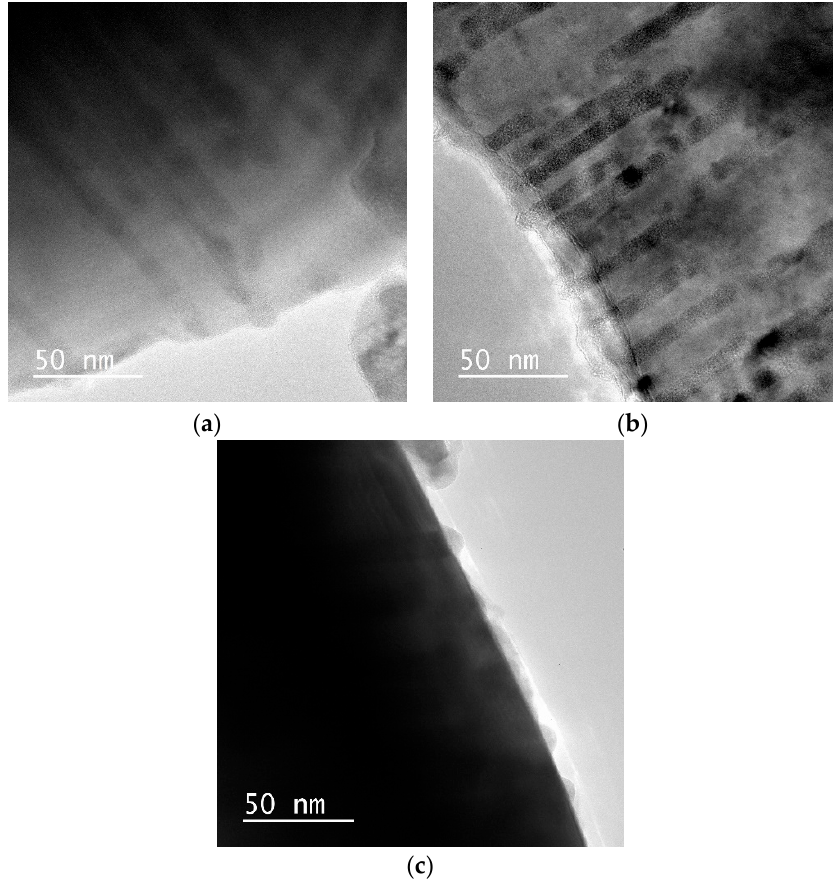
Figure 1. Bright field images of ion tracks induced in ( a ) LiNbO 3 , ( b ) ZrSiO 4 , and ( c ) Gd 3 Ga 5 O 12 irradiated with 200 MeV Au 32+ at an oblique incidence angle. The images were taken at relatively low magnification.